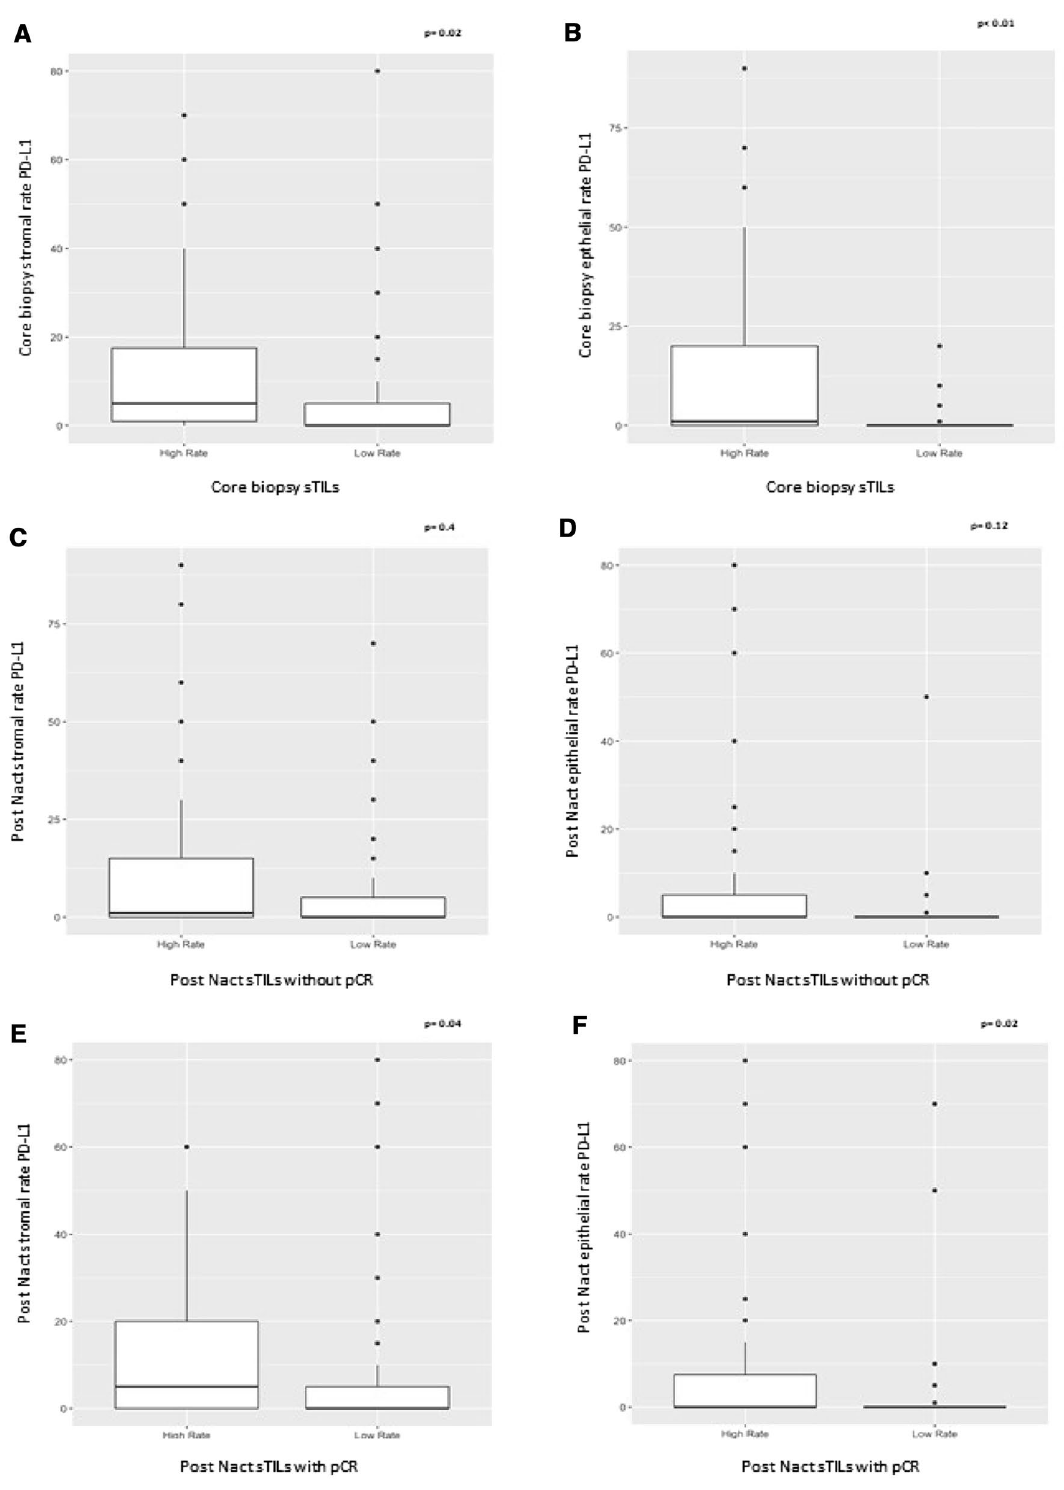
Figure 2. In the y-axis, PD-L1 expression is shown as the linear percentage of stained epithelial or stromal cells. In the x-axis, sTIL counts are indicated. ( A , C , E ) correspond to the values in stromal cells. ( B , D , F ) correspond to epithelial values. In core needle biopsies (pre-treatment) PD-L1 expression is correlated with sTILs, for both epithelial and stromal compartments ( A , B , p = 0.02 and p < 0.01, respectively). The same happened in post- NACT specimens when all cases (with residual disease and pCR) were included (Figures E and F, p = 0.04 and p = 0.02, respectively). However, when only cases with residual disease are considered, this relation was not present ( C , D , p = 0.40 and p = 0.12,